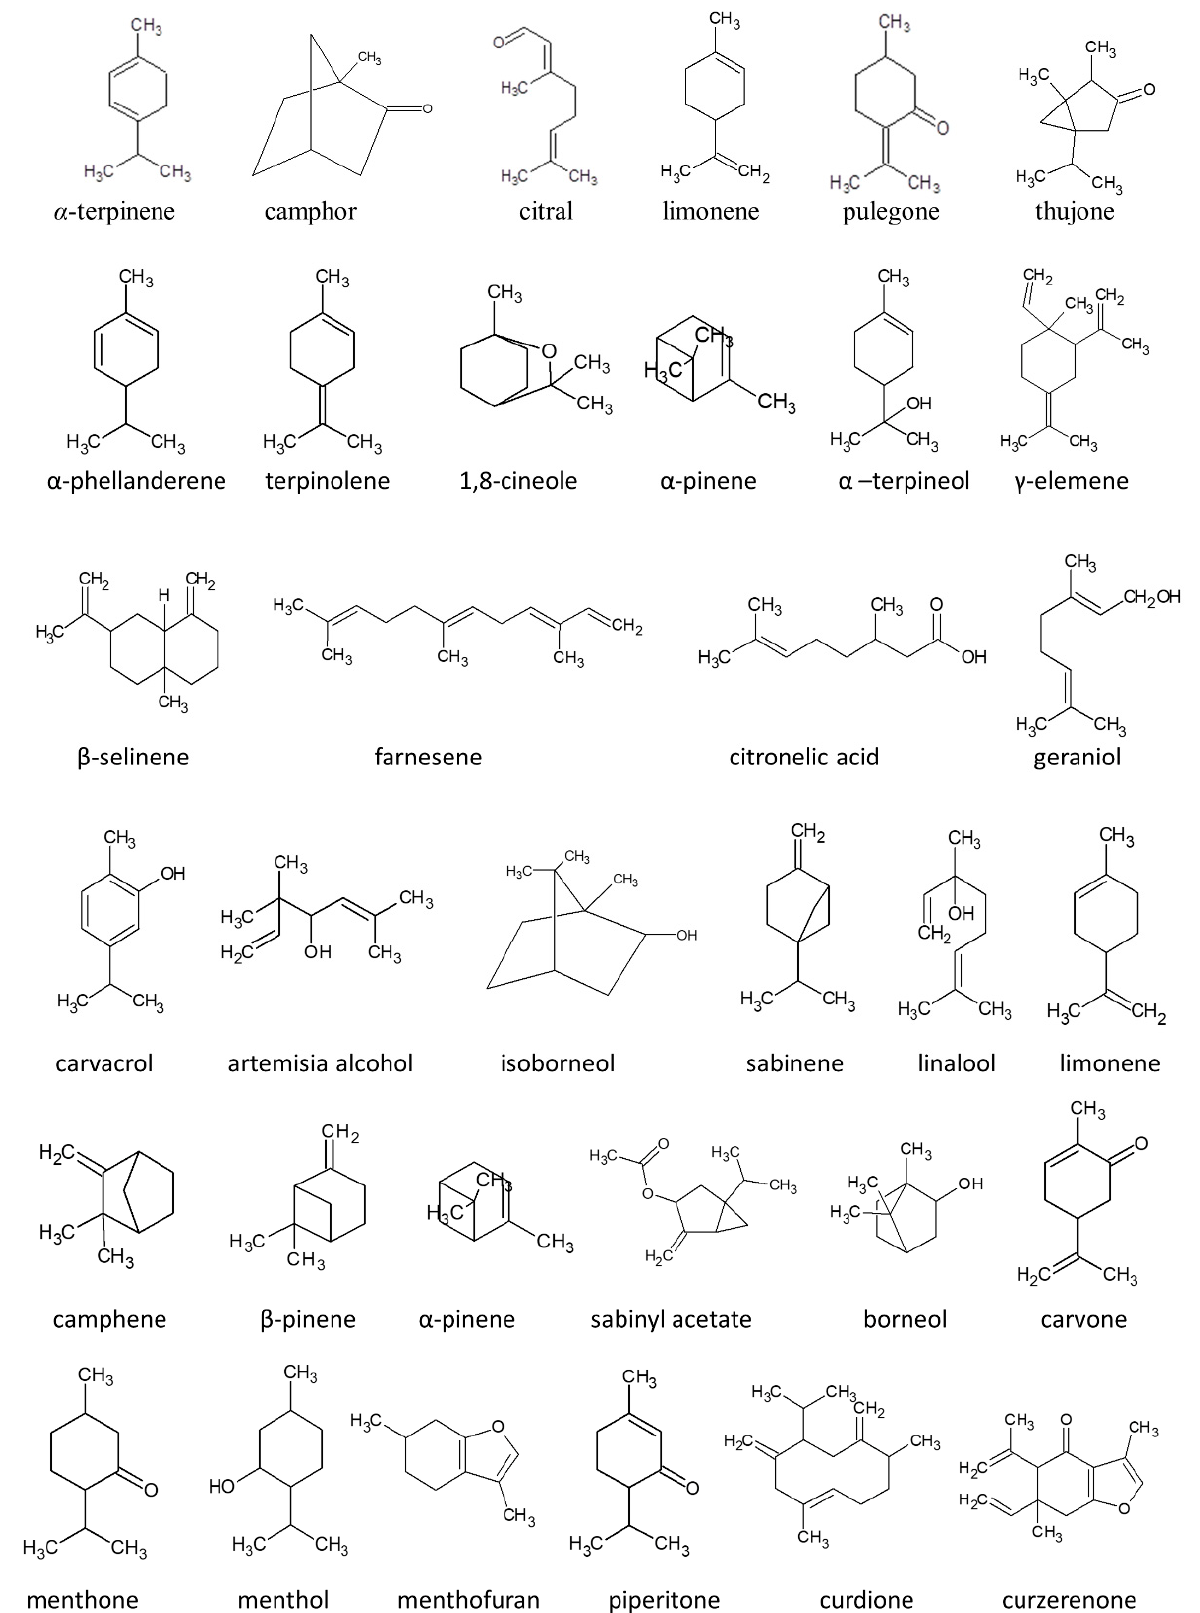
Figure 2. Structures of selected terpenes and their derivatives.